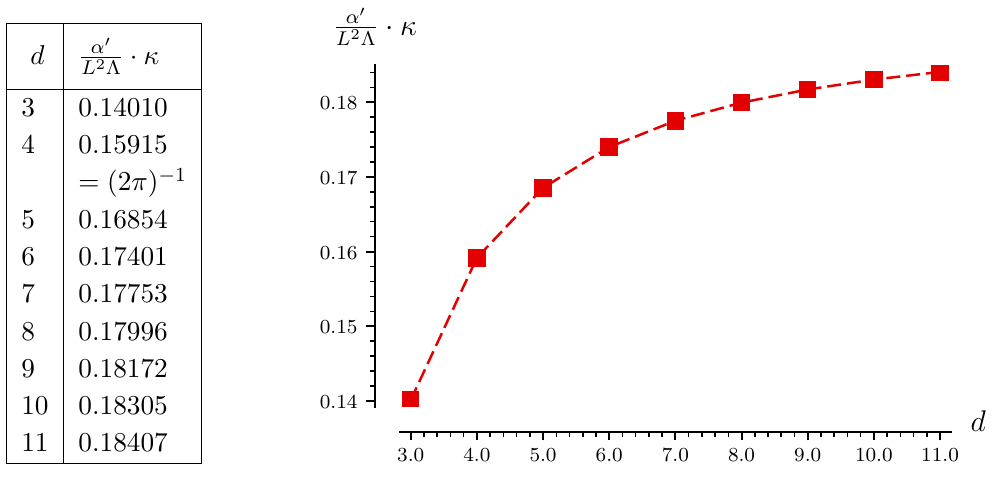
Table 1. Subleading term. Figure 7. Subleading term (cid:20)